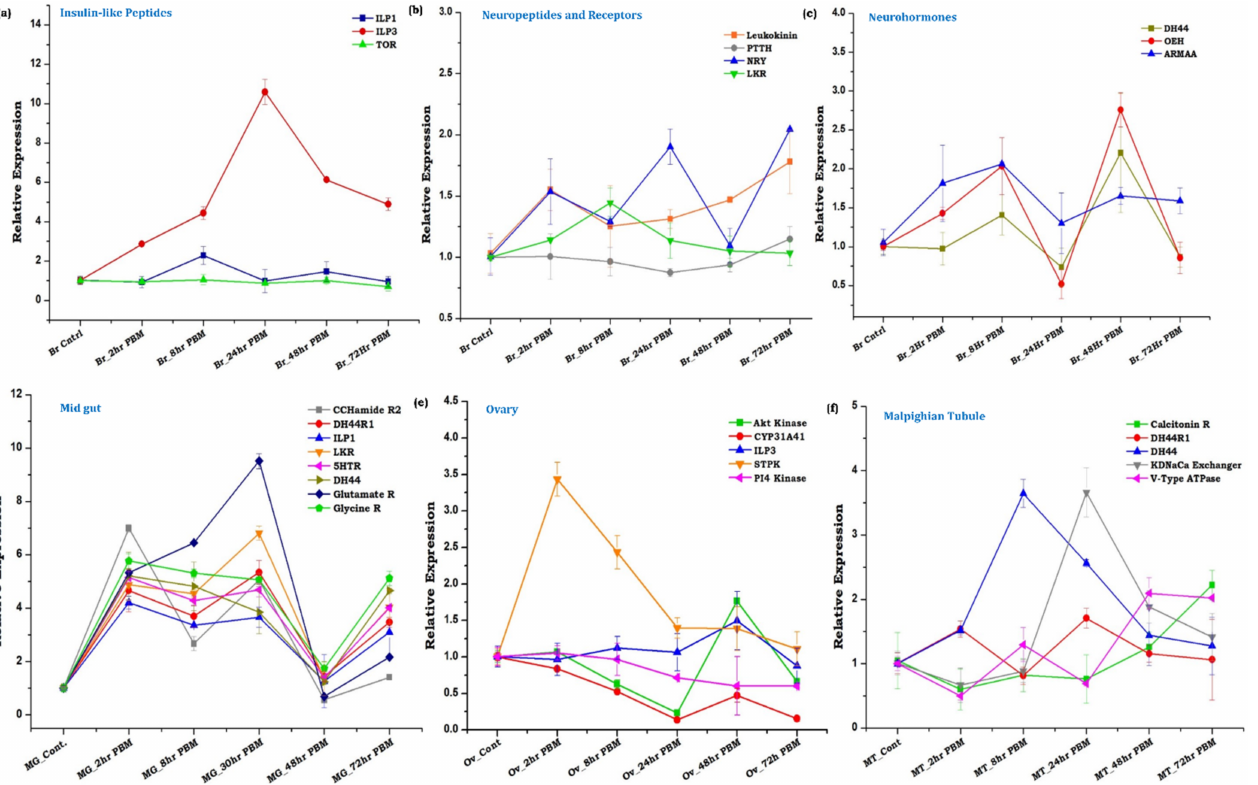
Figure 3. Metabolic switch modulates tissue-specific neuro-modulator transcripts expression. ( a – c ) Transcriptional expression profiling of Insulin-like-peptides, neuropeptides, neurohormones, and receptor genes in the brain tissue during the metabolic switch. Statistical analysis using two-way ANOVA and Tukey’s test implied that the expression change of the respective genes is statistically significant for insulin-like-peptides p ≤ 0.007; neuropeptides and receptors p ≤ 0.009, but for neuro- hormones, it was non-significant p ≤ 0.2 ( n = 25, N = 4); ( d ) Relative expression profiling of a subset of neuromodulator genes in the midgut of naïve and blood-fed mosquitoes at the same time point described above. Statistical analysis using two-way ANOVA implied that the expression change of the respective genes is statistically significant p ≤ 0.005 ( n = 12, N = 4) ; ( e ) Transcriptional profiling of genes involved in signal transduction during vitellogenesis in the ovary. Statistical analysis using two-way ANOVA and Tukey’s test indicated that the expression change of the respective genes was statistically significant at p ≤ 0.002 ( n = 12, N = 4); ( f ) Relative gene expression analysis of diuresis- related genes in the Malpighian tubule of naïve and blood-fed mosquitoes. Statistical analysis using two-way ANOVA and Tukey’s test indicates that the expression change of the respective genes is non-significant at p ≤ 0.4 ( n = 25, N = 4). For Statistical analysis, all the time points and all the transcripts are compared together using two-way ANOVA and the means of the time points showed statistically significant. ( n = number of mosquitoes from which the respective tissue was dissected and pooled for each independent experiment; N = number of biological